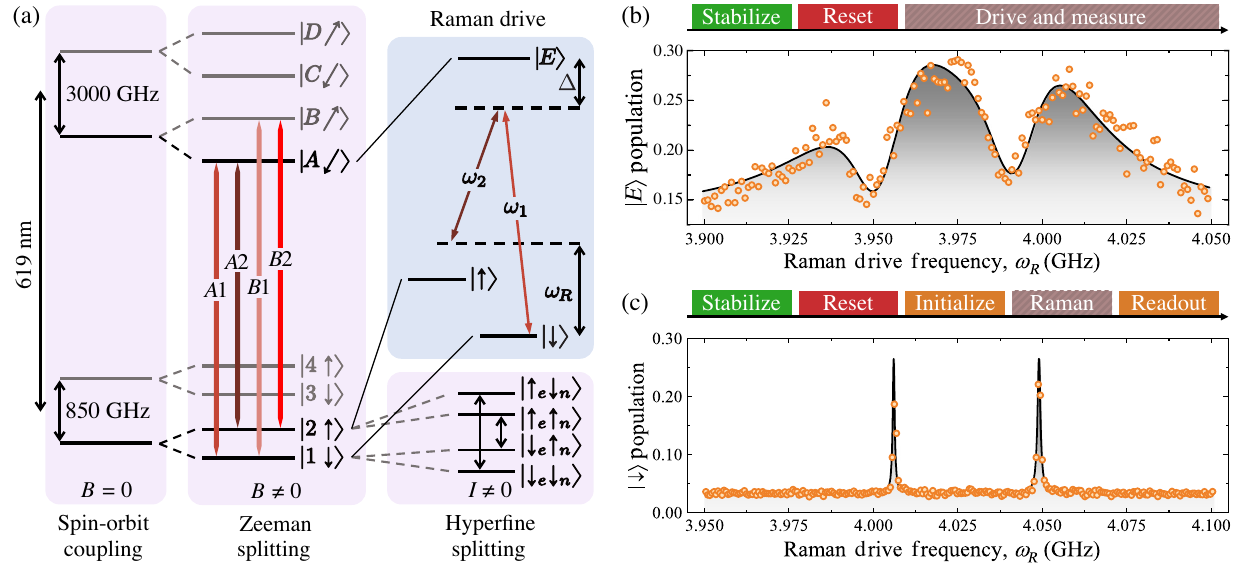
FIG. 1. SnV and Raman drive. (a) Lilac panels: energy levels of the SnV split by spin-orbit coupling (left), Zeeman splitting (middle), and hyperfine splitting (right). Blue panel: qubit defined by the j ↓ i and j ↑ i electronic levels. An optical lambda scheme is defined by two optical fields ω 1 and ω 2 detuned by Δ from the excited state j E i . The Raman drive frequency ω R ¼ ω 1 - ω 2 is the energy offset between the two fields. (b) j E i population plotted in orange circles as a function of ω R for Δ ¼ 0 and 200 mT magnetic field strength applied at 54.7° relative to the SnV symmetry axis. The pulse sequence consists of an approximately 10 - μ W green stabilization pulse for 50 μ s, B 2 reset pulse for 30 μ s, and Raman drive with p ¼ 40 ð 4 Þ nW for 2 μ s. The solid curve is a three-level model describing coherent population trapping. (c) j ↓ i population plotted in orange circles as a function of ω R for Δ ¼ 600 MHz at 204-mT magnetic field strength. After the stabilize and reset pulses, the sequence includes an initialization pulse for 30 μ s, a Raman drive with p ¼ 40 ð 4 Þ nW for 1 μ s, and a readout pulse on A 1 for 30 μ s. The solid curve is a two-Lorentzian fit resulting in an average linewidth of 900(200) kHz and spin resonances split by 42.6(4)